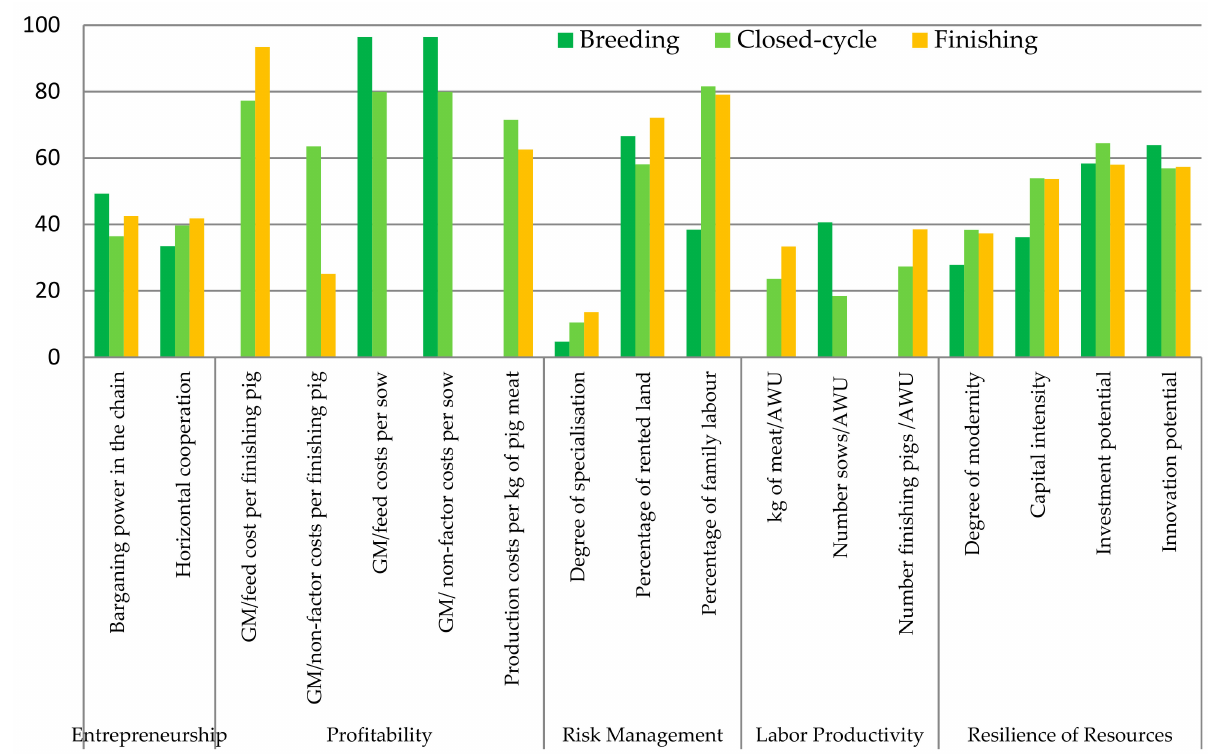
Figure 3. Results of the economic sustainability assessment of the theme “resilience” on the pig farms according to scaled indicators (results of indicators recalculated to a scale ranging from 0% to 100%, where 100% is the highest sustainability level and 0% is the lowest sustainability level. Source: Own